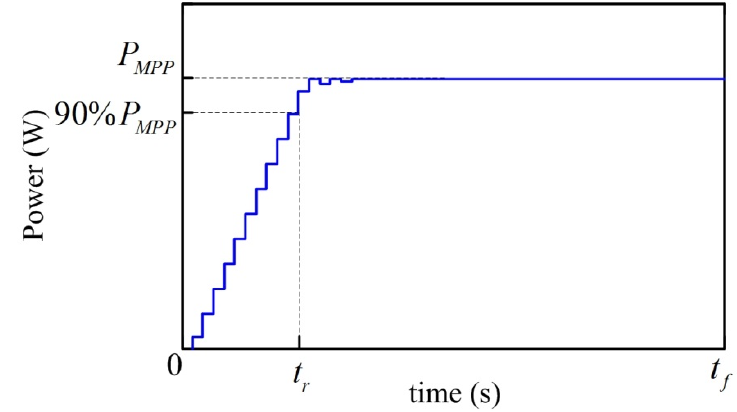
Figure 10. Concept of computing the fitness value for one irradiance level.